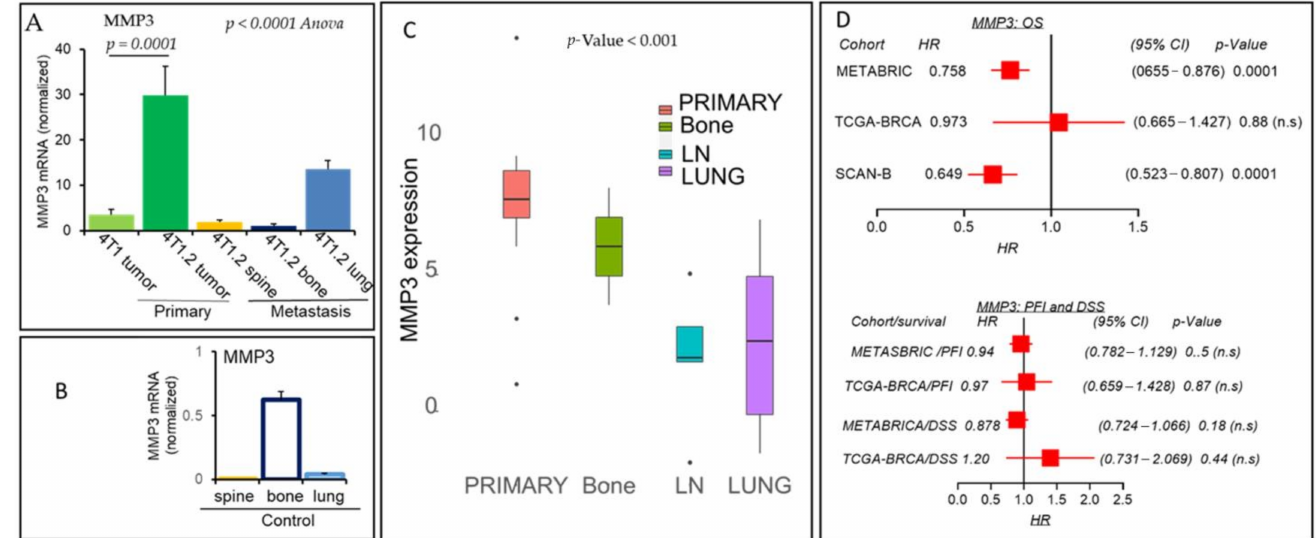
Figure 3. MMP3 is downregulated at the metastatic sites vs. primary tumor and positively impacts breast cancer patients’ survival. MMP3 mRNA levels were determined by qPCR analysis in the primary tumors, metastatic lesions ( A ), and corresponding control tissues ( B ) of mice, as mentioned in Figure 2A. MMP3 mRNA levels were normalized with GAPDH. Data are mean ± SEM, one-way ANOVA p = 0.0001, Tukey’s post hoc test, p < 0.05, n = 3. ( C ) Boxplots show a high MMP3 expression score of primary tumors vs. metastasis to bone, LN, or the lung. Boxplots analyses, Kruskal–Wallis test (non-parametric method), p < 0.05; Tukey’s t -test with medians and inter-quartile ranges, p < 0.05, as a significant difference among groups having different sample sizes. ( D ) Patients with a high MMP3 expression score and association of survival in three breast cancer cohorts. Overall survival (OS) in METABRIC, TCGA-BRCA, and SCAN-B cohorts (upper) or progression-free survival (PFI) and disease-specific (DSS) survival in METABRIC and TCGA-BRCA cohorts along with HR, CI, and p values are shown (lower). Note: METABRIC and SCAN-B OS data for a high expression score of MMP3 is significant (HR < 1, p =